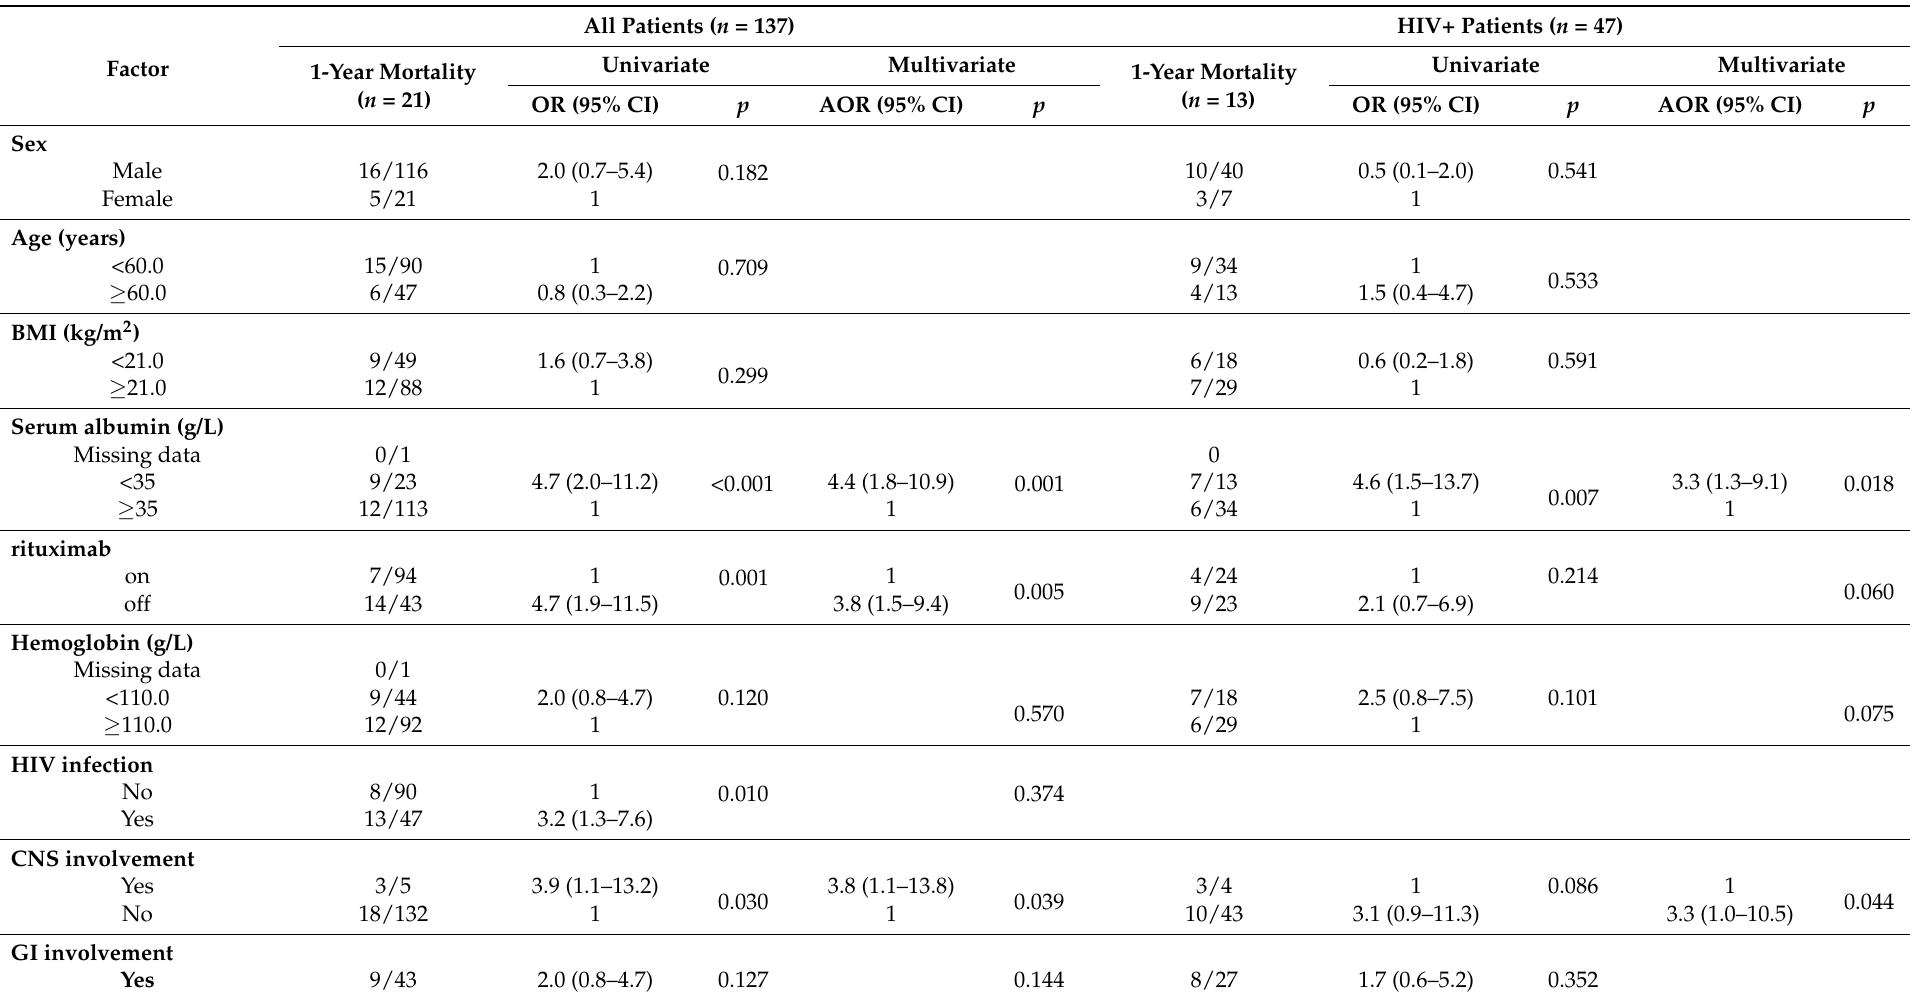
Table 4. Risk factors for 1-year mortality in DLBCL patients in univariate/multivariate Cox proportional hazards models. All Patients ( n = 137) HIV+ Patients ( n = Factor